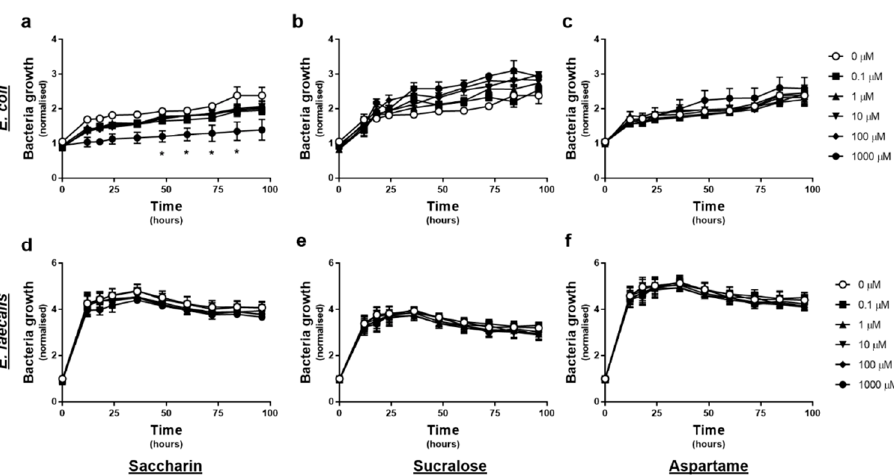
Figure 1. Only the artificial sweetener saccharin affects E. coli model gut bacteria growth at high concentrations. E. coli (panels a – c ) and E. faecalis (panels d – f ) growth was measured, following exposure to the artificial sweeteners (0 to 1000 µ M), saccharin (panels a , d ), sucralose (panels b , e ), and aspartame (panels c , f ), for up to 96 h. Specific bacteria for each study are included in underlined text. Data are presented as mean ± standard error mean (S.E.M.). * p < 0.05 versus 0 µ M at the same time